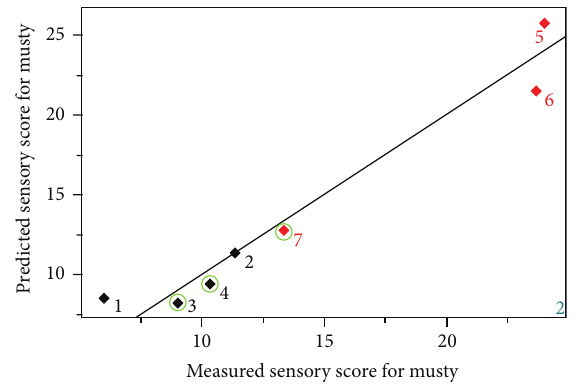
Figure 5: Comparison of measured sensory scores for musty and their predictions from the autoscaled VOC data set by Principal Component Regression of the 2012 tomato samples from the Basilicata region (black symbols) and the Emilia Romagna region (red symbols). Green circles in the plot indicate organic